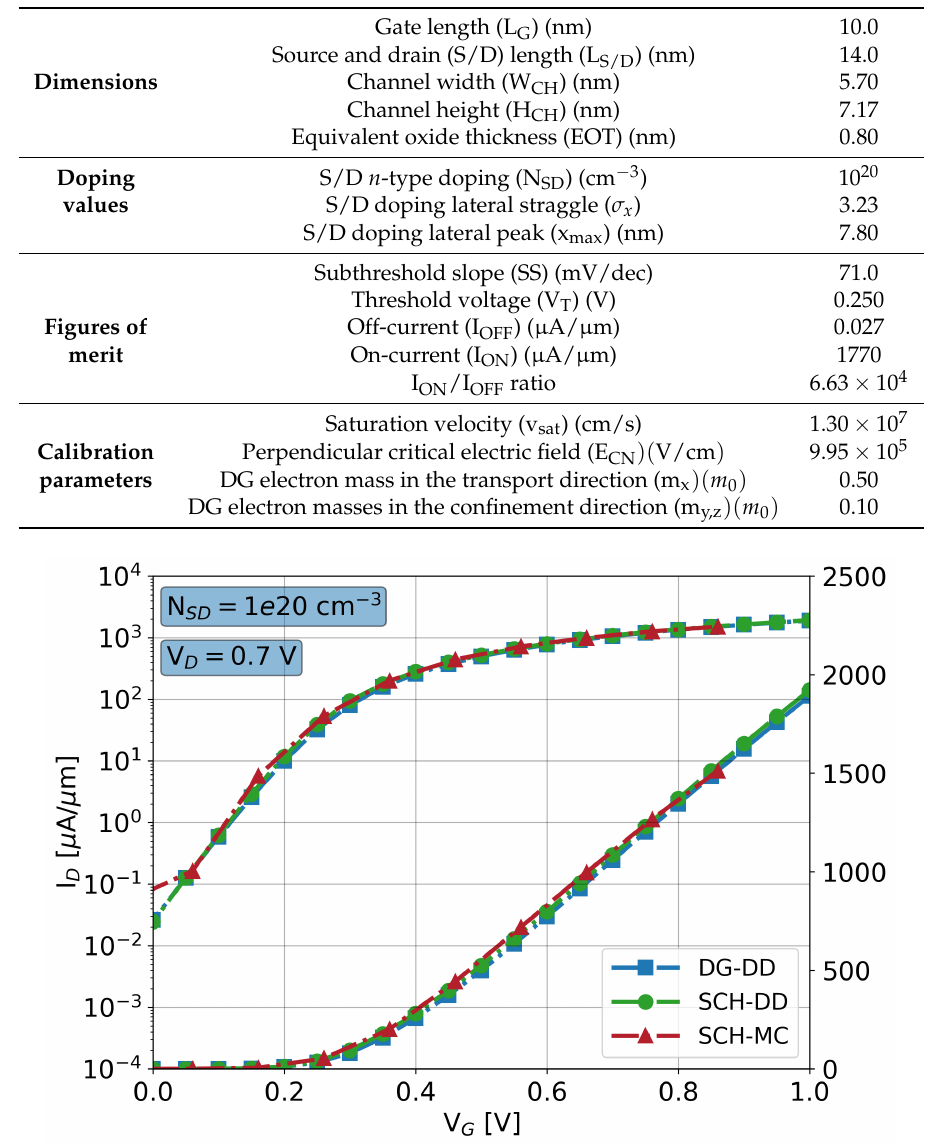
Table 1. Device dimensions, doping values, main FoMs and calibration parameters for the 10 nm gate length Si GAA-NW FET.